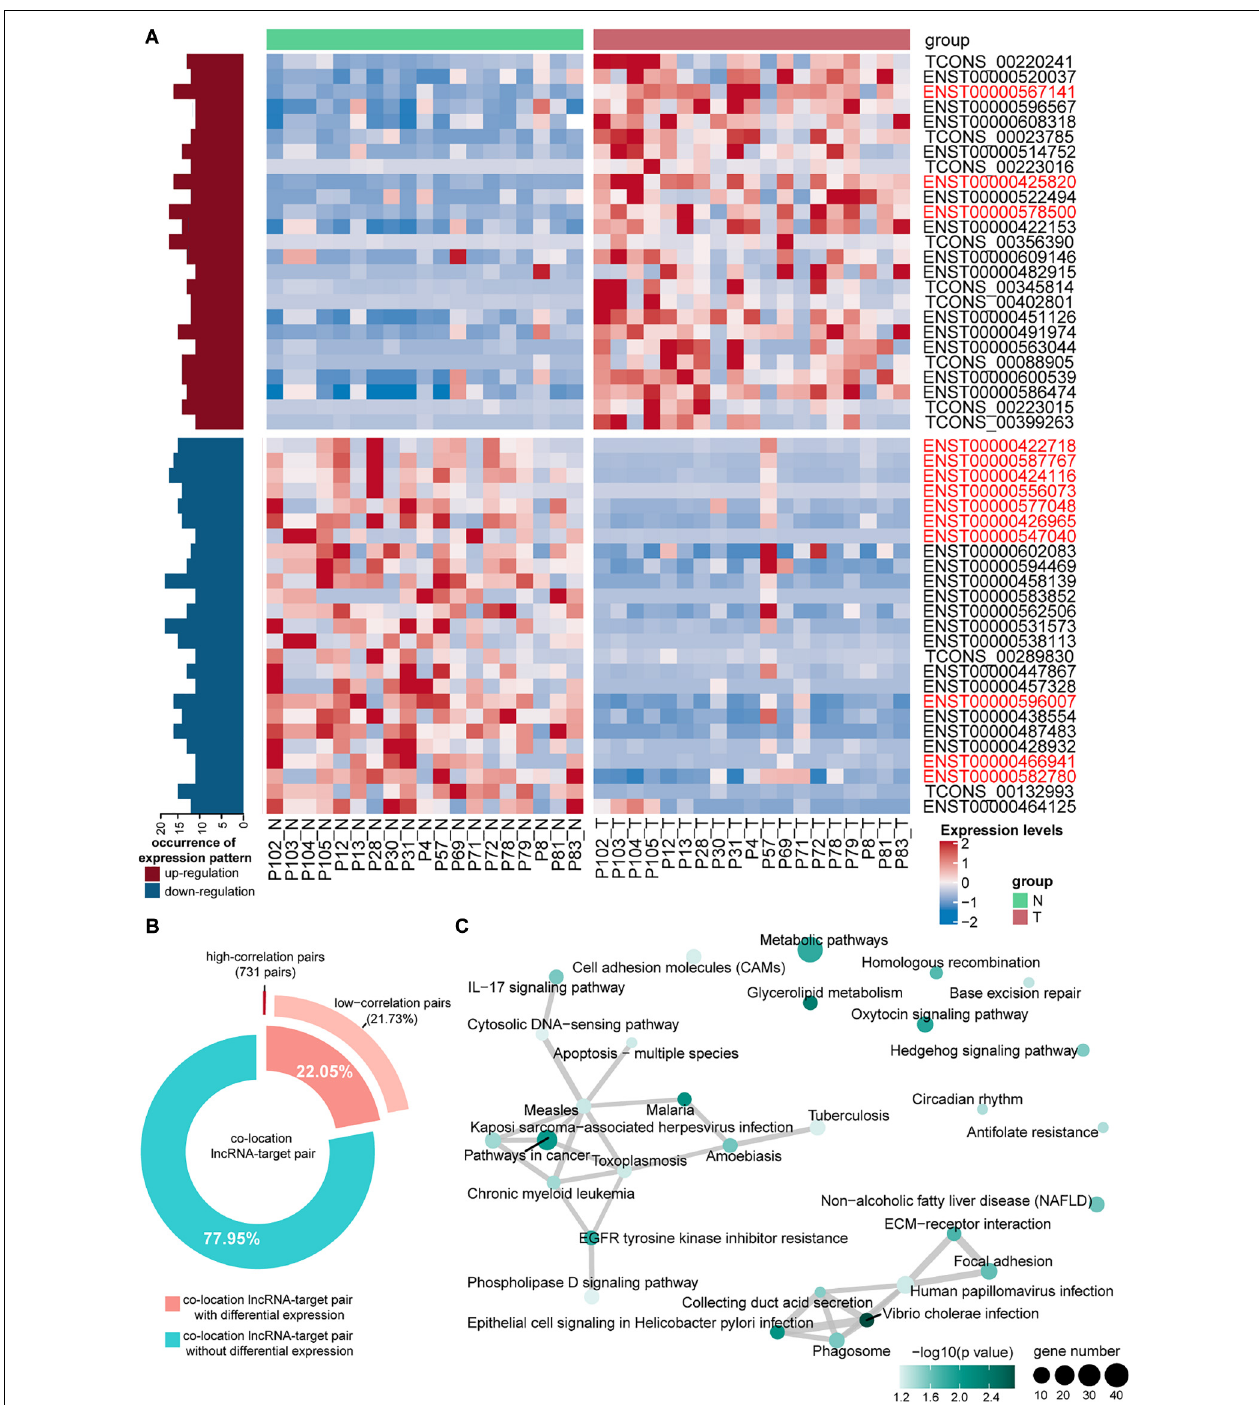
FIGURE 1 | Characterization and functional analysis differentially expressed LncRNAs (DE-lncRNAs) and differentially expressed target genes (DEGs). (A) Heatmap with expression characteristics of differentially expressed lncRNAs in tumor and normal tissues. The order of DE-lncRNAs was determined by occurrence in comparison group. The top 50 most differentially expressed lncRNAs used for clustering were plotted, of which 25 were up-regulated and 25 down-regulated, respectively. The occurrence of up-regulated and down-regulated patterns were shown as red and blue bars on the left side. Samples were also annotated on top. The DE-lncRNAs verified in TCGA TNBC cohorts were highlighted in red. (B) LncRNA target prediction analysis based on positional relationship and expression correlation (as described in “Materials and Methods”). (C) Pathway enrichment analysis of target genes differentially expressed lncRNAs. The relationships of important biological processes (top 30) were depicted by network. The color was scaled by P -values, and the sizes of the dots represented the percentage of each term.